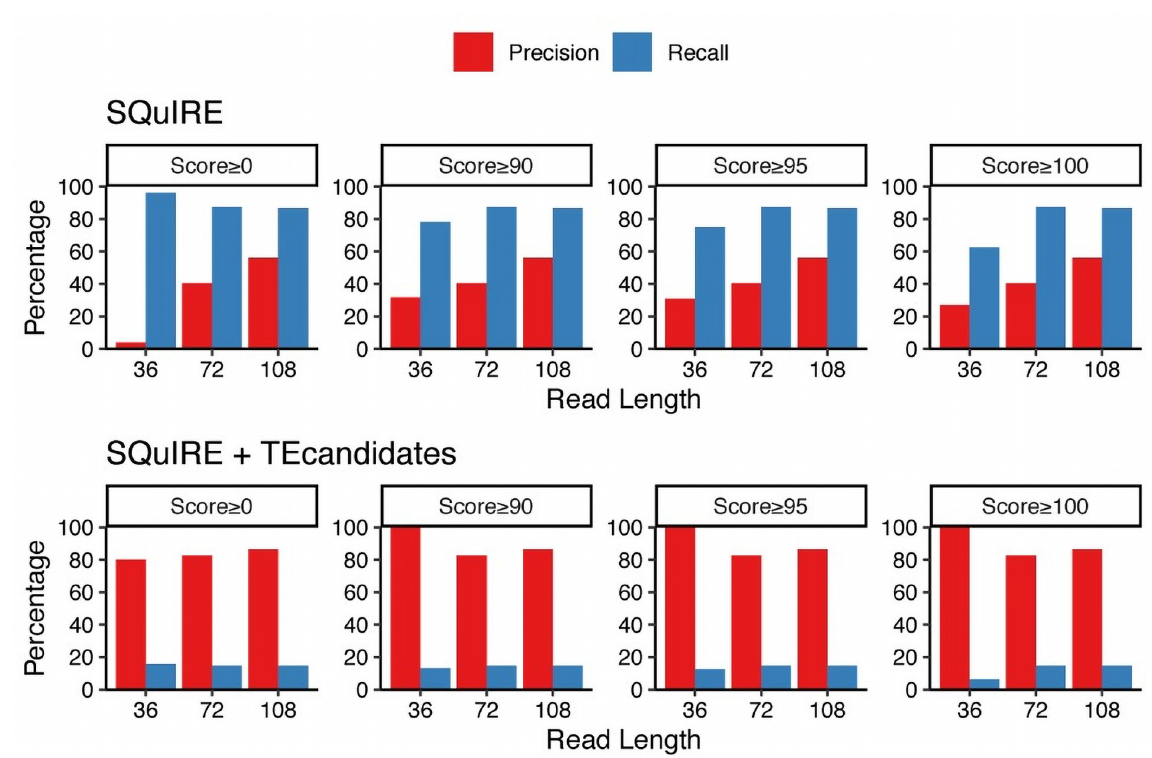
Fig 3. Bar plots of Precision (red) and Recall (blue) for the simulated experiments. The Upper half are the results of using SQuIRE alone, and in the lower half are the results of using SQuIRE and TEcandidates. Each bar plot corresponds to the result using a specific SQuIRE score